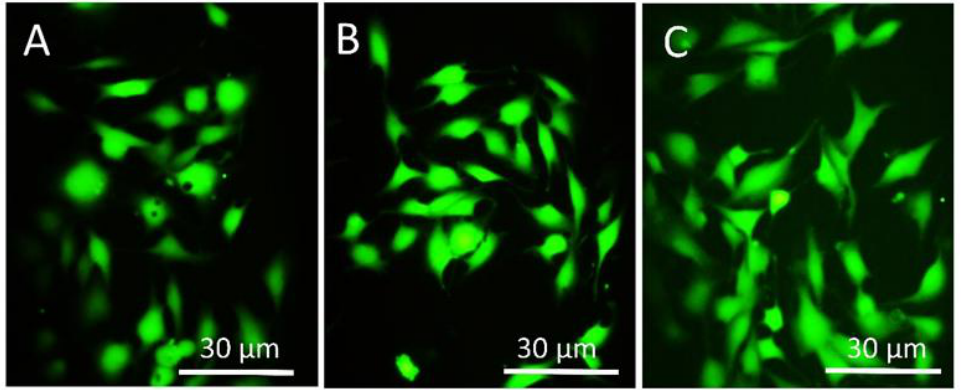
Figure 13. Confocal images of MG63 cells on the machined ( A ), RT etched ( B ), and HT etched ( C ) surfaces stained with Calcein green and PI after 24 h of culture.